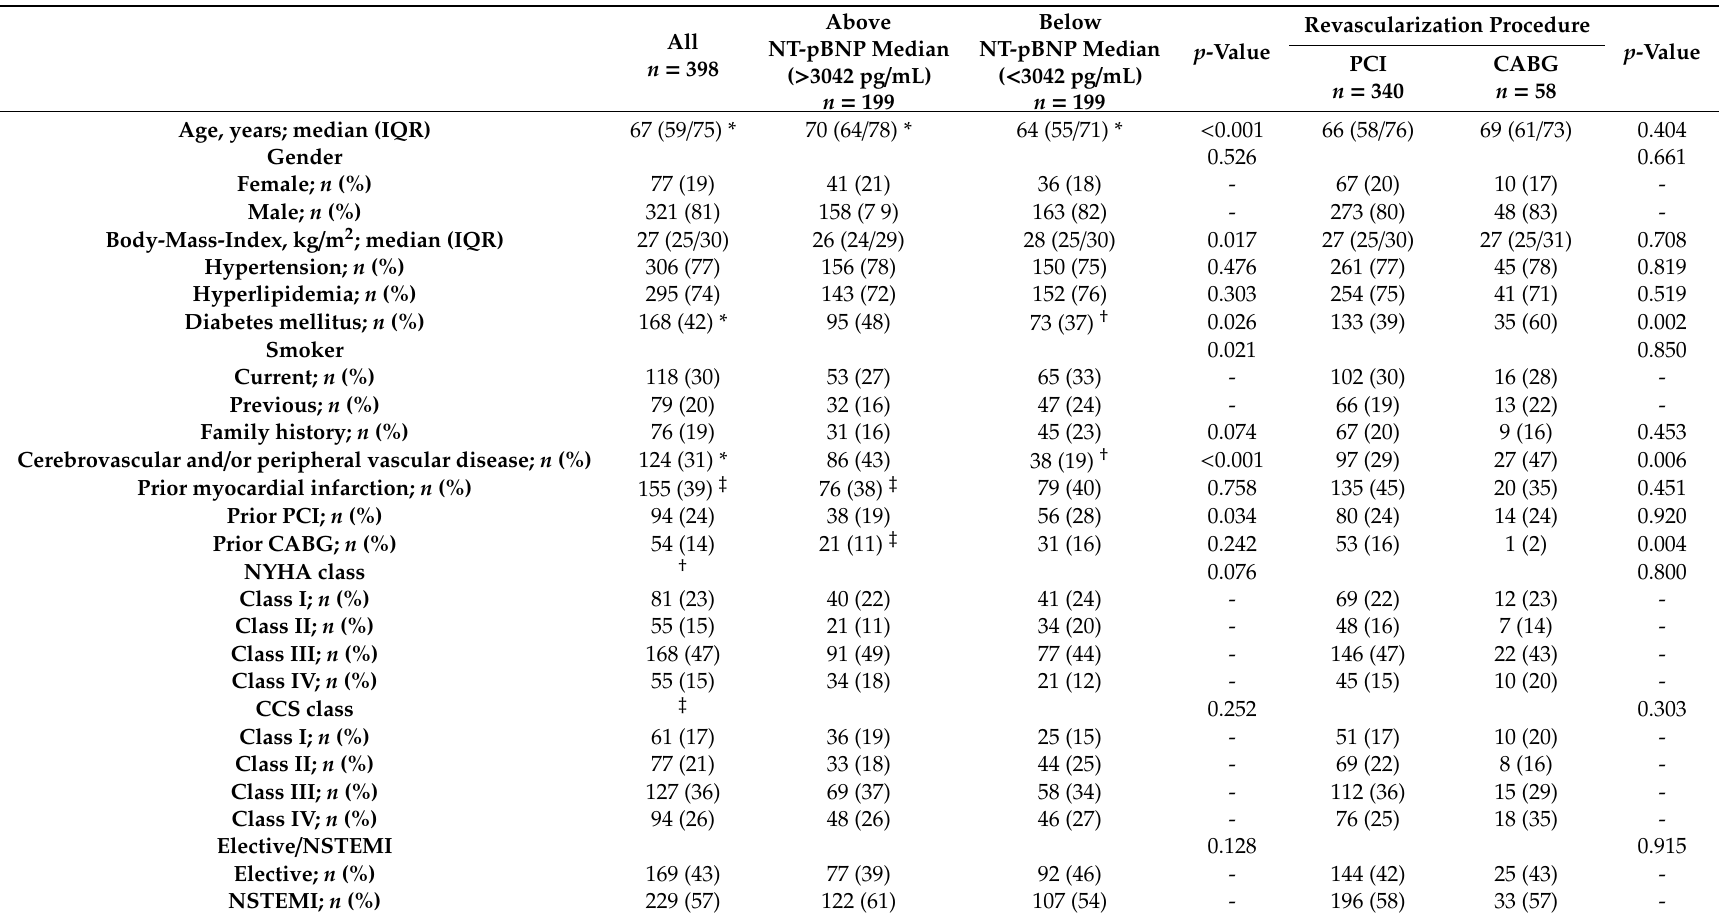
Table 1. Demographics, comorbidities and clinical presentation of all patients, subgroups with above and below NT-pBNP median (3042 pg / mL, interquartile range (IQR) 1313 / 8473), and subgroups according to the type of revascularization